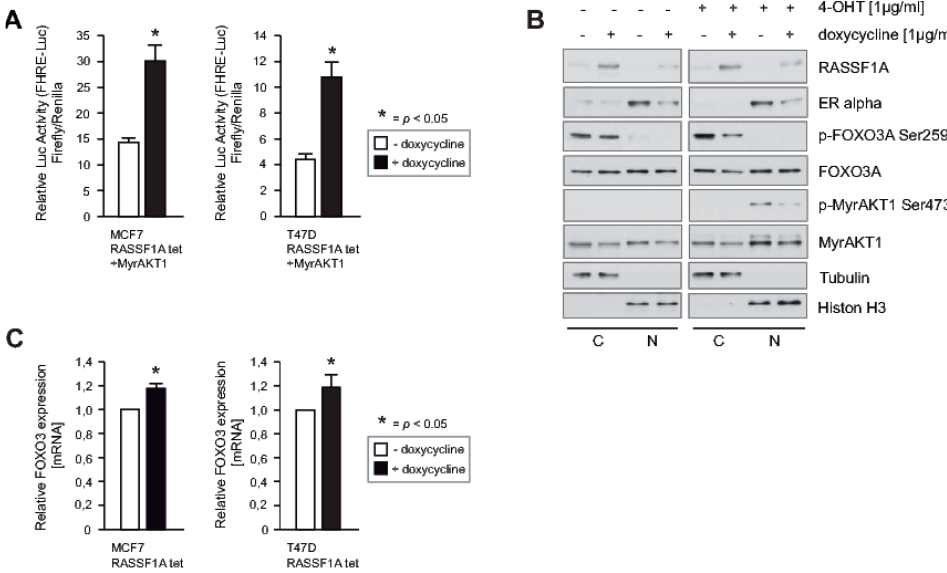
Figure 5. RASSF1A increases FOXO3A transcriptional activity through the suppression of AKT- mediated inhibitory phosphorylation and increased expression of FOXO3A. ( A ) Conditional RASSF1A MCF7 (left panel) and conditional RASSF1A T47D cells (right panel) [3] were